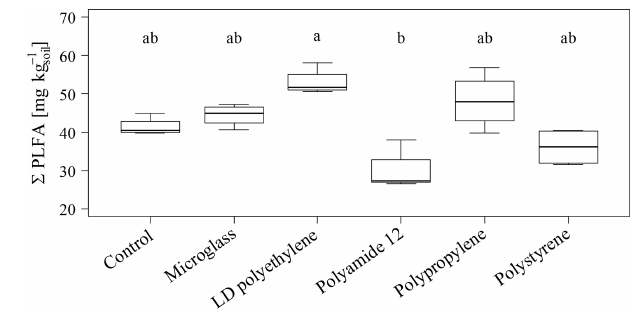
Figure 2. Sum of total phospholipid fatty acids as microbial mark- ers in an incubated Chernozem after 80d. Different lowercase let- ters indicate significant differences between the treatments accord- ing to a multiple comparison with the Dunn’s test ( n = 4, p< 0 .